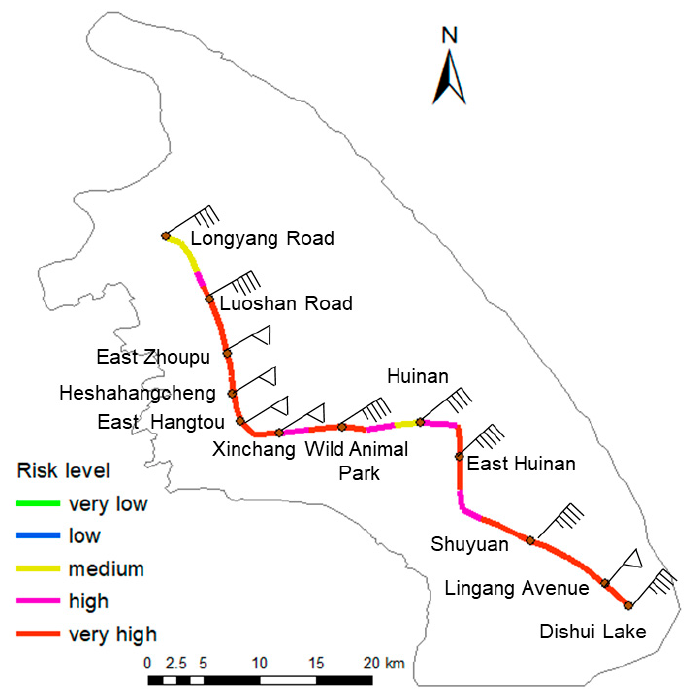
Figure 13. WR2 determined risk levels (see Table 2 values associated with the levels) of Shanghai Metro Line 16 during Typhoon Chan-hom landfall (7:50 LST 11 July 2015). See Figure 1 for location within Shanghai.